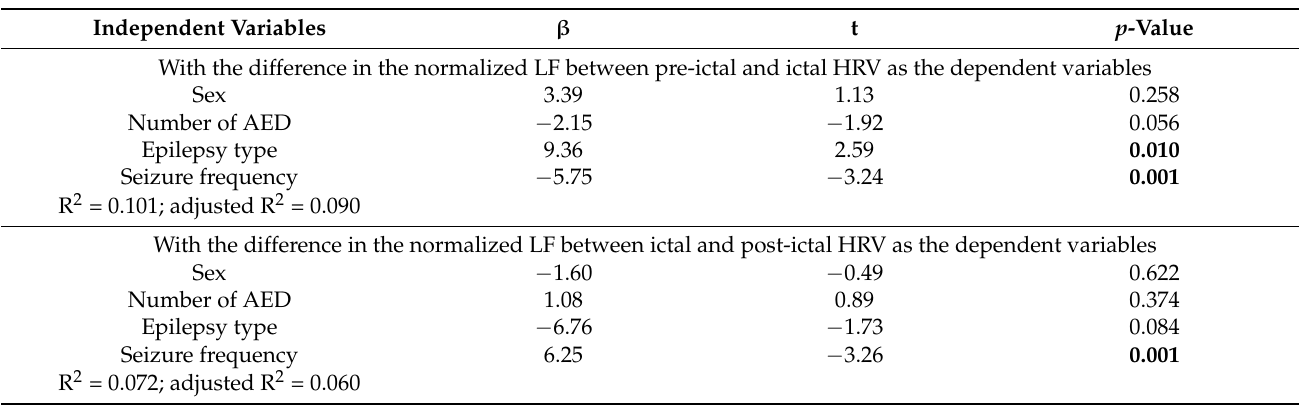
Table 4. Multiple linear regression analysis with HRV parameters.